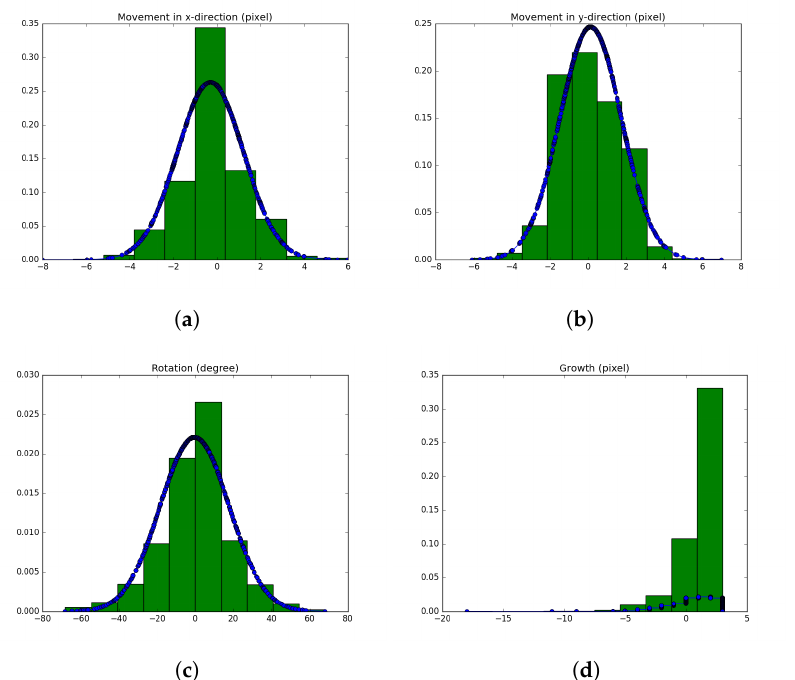
Figure 8. Distribution of per frame changes in position, orientation, and length, derived from fitting our synthetic universe images to the corresponding actual video frame. We see that the motion in the x and y directions tend to be about 1 pixel in magnitude per frame, while rotation average about 20 degrees and growth about 1–3 pixels per frame. ( a ) Movement in x-direction (pixels); ( b ) Movement in y-direction (pixels); ( c ) Rotation (degrees); ( d ) Growth